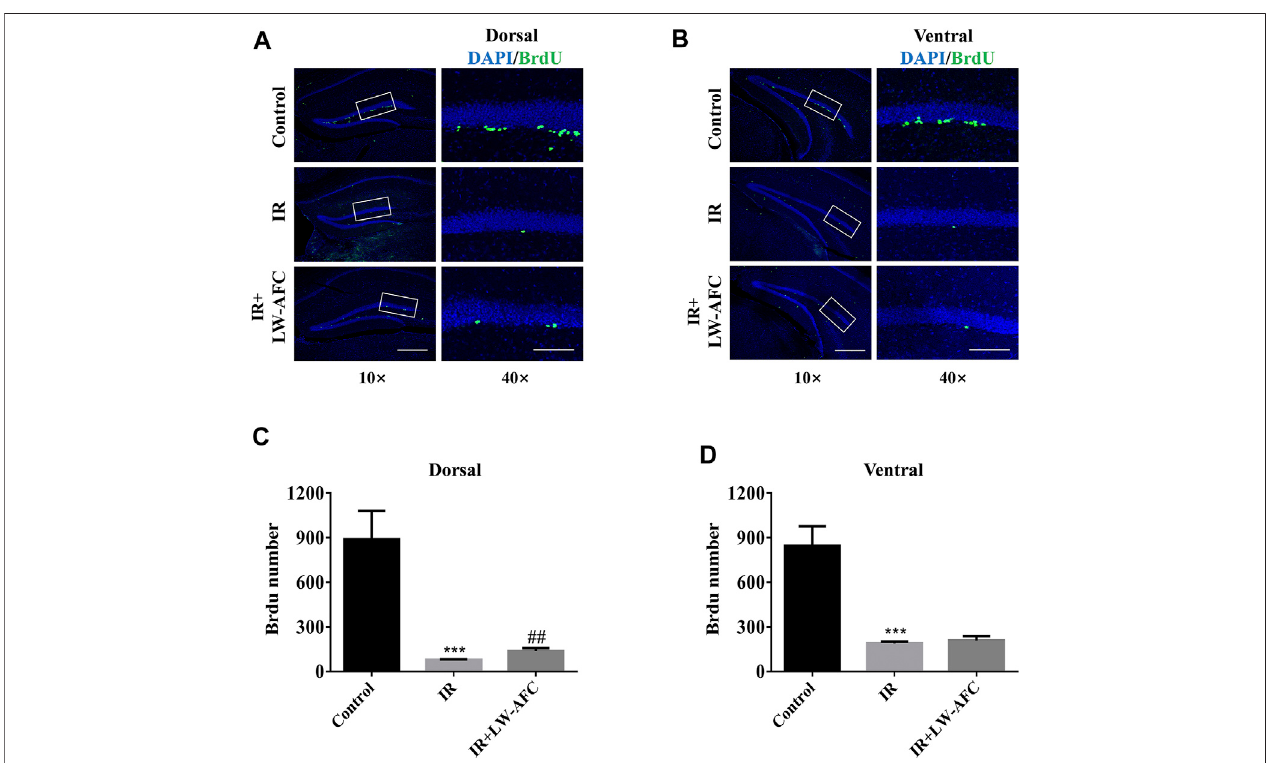
FIGURE 4 | LW-AFC promotes the proliferation of neural stem cells preferentially in the dorsal hippocampus of IR mice on day 1 after irradiation. Representative immuno fl uorescence images of BrdU-positive cells in the (A) dorsal hippocampus and the (B) ventral hippocampus. The area of white square frame in the left image indicatestheenlargedimageofBrdU-positivecellsintheright.Theconfocalimagesintheleftareof10 × ,andtheenlargedimagesintherightareof40 × .Quanti fi cationof BrdU-positive cells in the (C) dorsal hippocampus and the (D) ventral hippocampus. The scale bar in the left image (cid:2) 300 μ m, and the scale bar of the enlarged image (cid:2) 100 μ m. The values denote mean ± S.D., n (cid:2) 4. *** p < 0.001, versus the control group; ## p < 0.01, versus the IR group. Abbreviation: IR, irradiation.